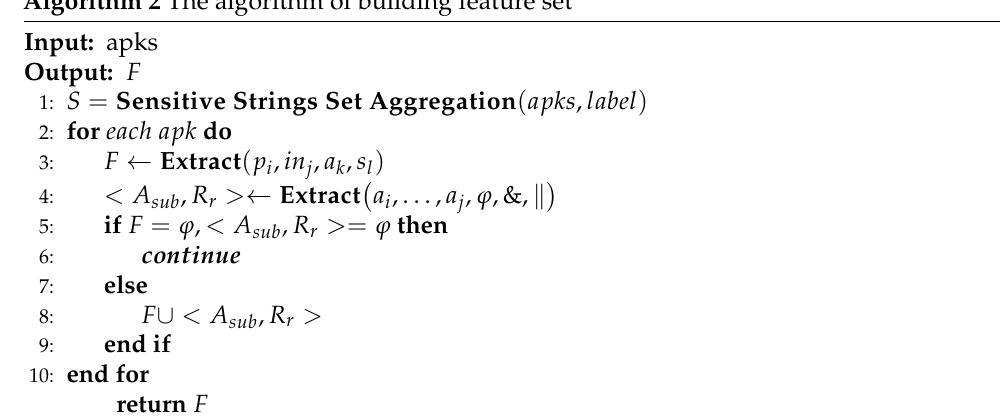
Algorithm 2 The algorithm of building feature